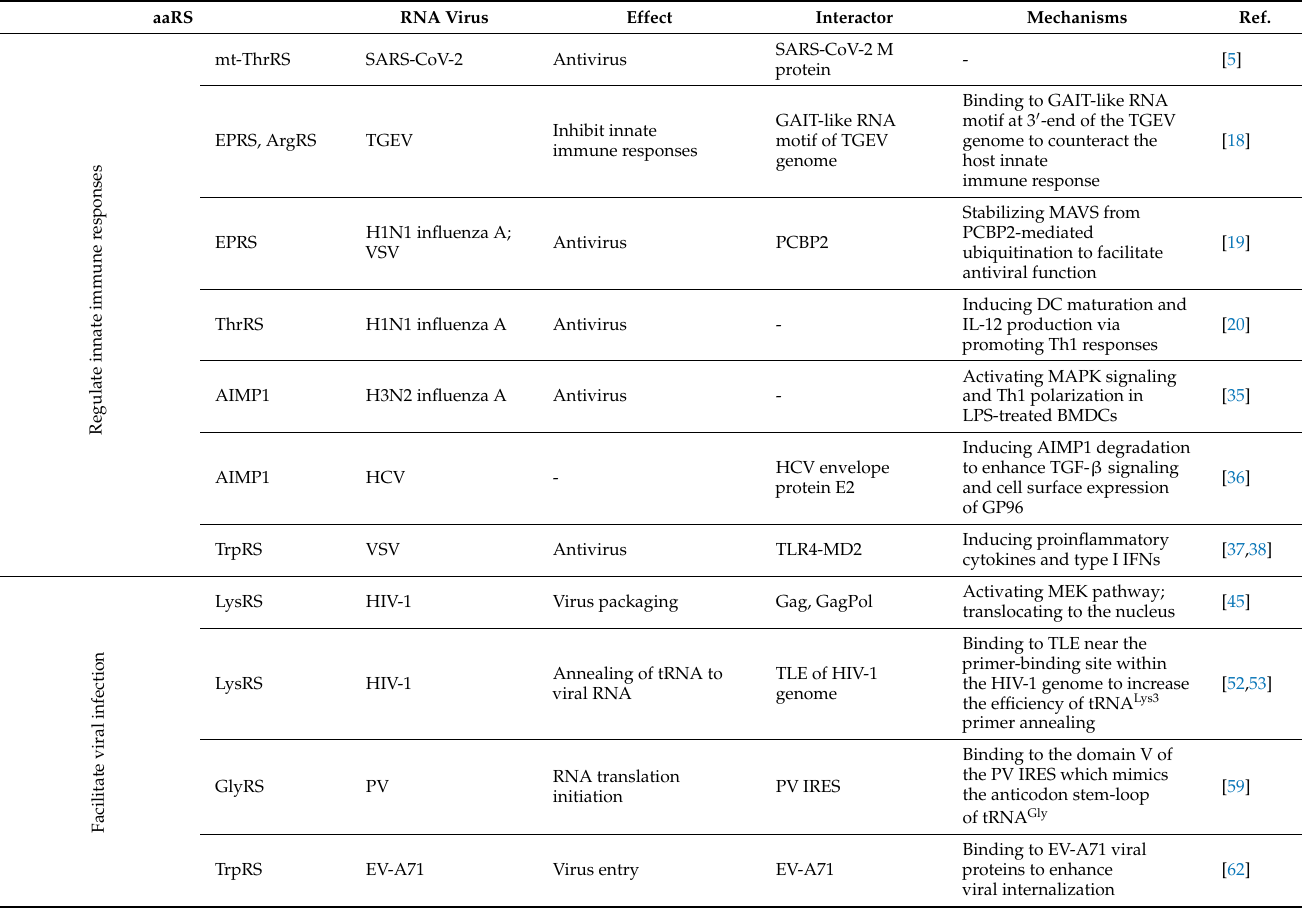
Table 1. Roles of aaRSs and AIMPs in RNA viral